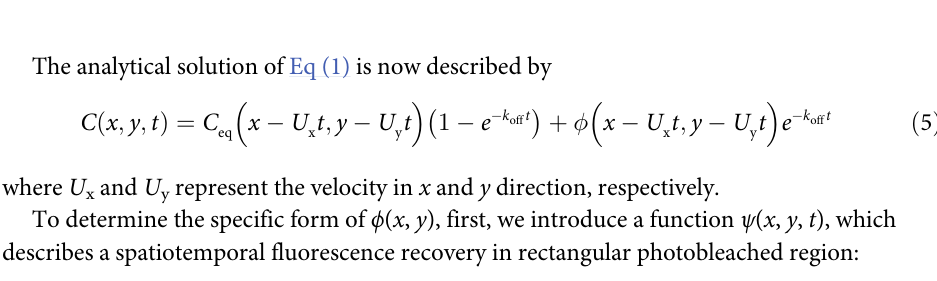
ffiffiffiffiffiffiffiffiffiffiffiffiffiffiffiffiffiffiffiffiffiffi R 2 þ 4 D